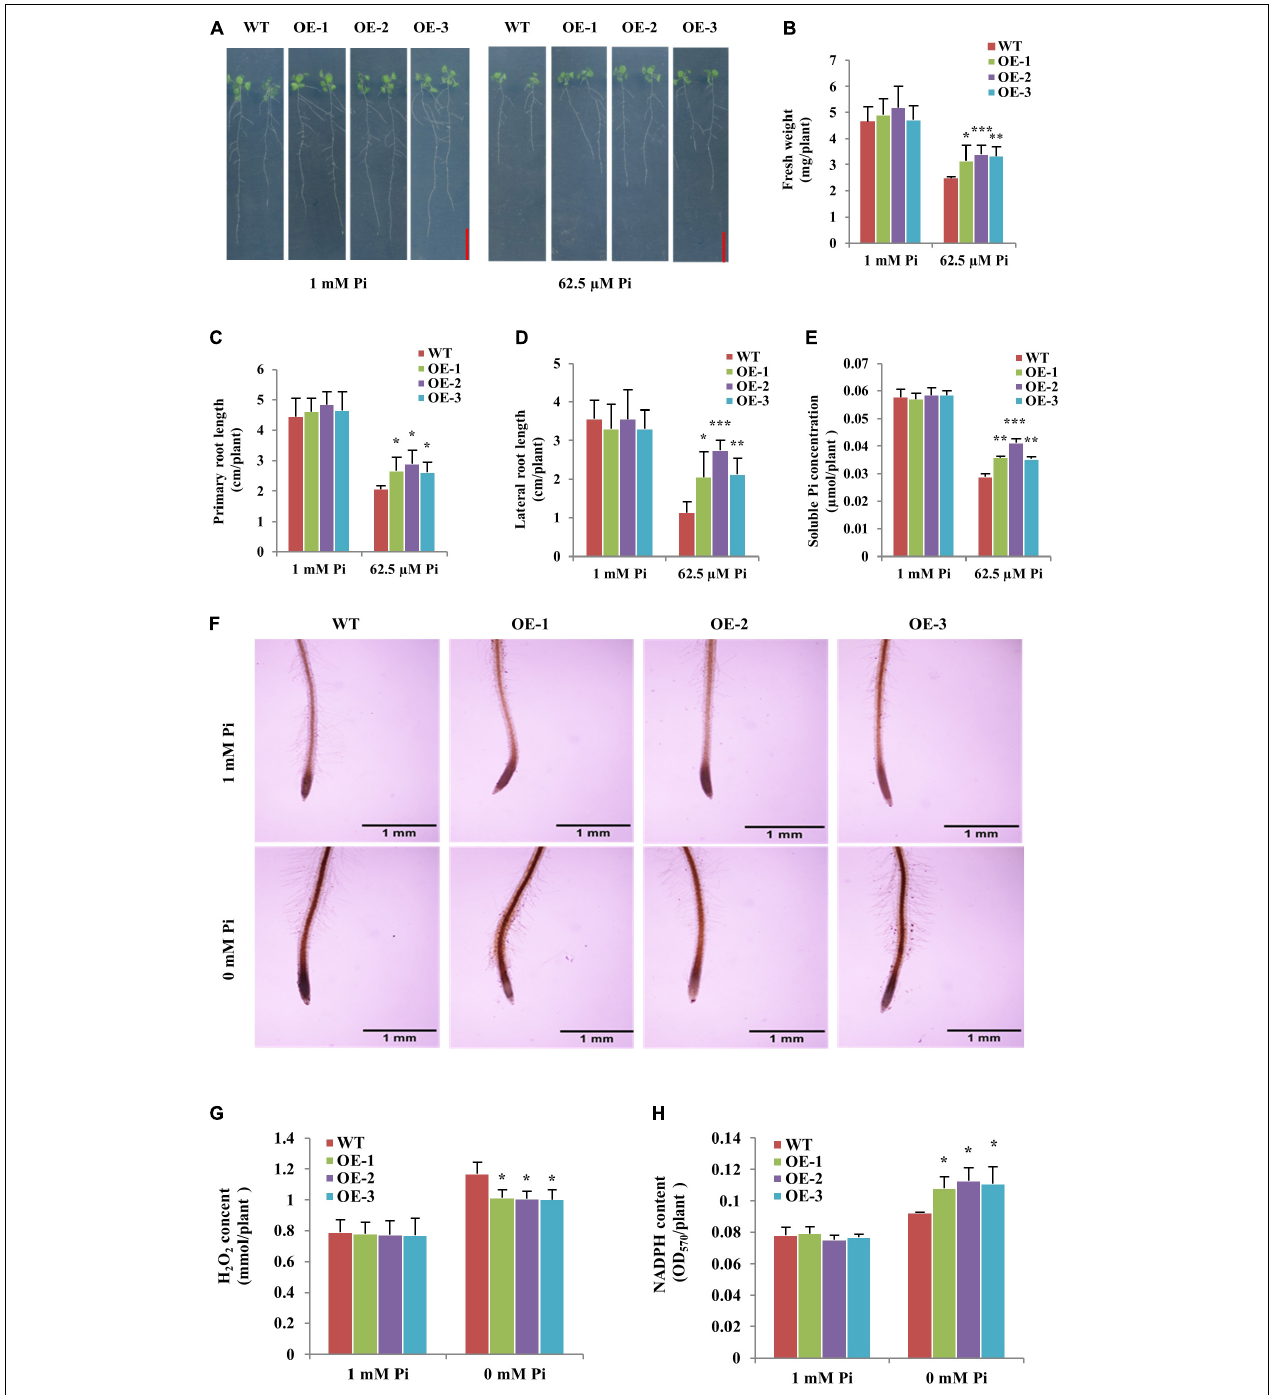
FIGURE 7 | Overexpression of Gm6PGDH1 improved root system development and Pi accumulation, and affected the oxidative damage in Arabidopsis under low Pi conditions. (A) Wild-type (WT) and Gm6PGDH1 -overexpressing transgenic Arabidopsis (OE-1, OE-2, and OE-3) were grown in a Hoagland medium with 1 mM Pi or 62.5 µ M Pi on vertically oriented Petri dishes for 14 days. Bars = 1 cm. (B–E) The fresh weight, primary root length, total lateral root length and soluble Pi concentration were determined in WT and transgenic Arabidopsis plants treated as above. Three independent experiments were performed. (F) Photographs showing DAB staining of 7-day-old WT and transgenic Arabidopsis seedlings treated with a medium with 1 mM Pi and 0 mM Pi for 36 h, respectively. Bars = 1 mm. H 2 O 2 levels (G) and enzyme activity of nicotinamide adenine dinucleotide phosphate (NADPH) (H) in all lines treated as (F) . Data are means ± SD ( n = 3). Data significantly different from the corresponding controls are indicated (Student’s t -test, * P < 0.05; ** P < 0.01; *** P < 0.001).